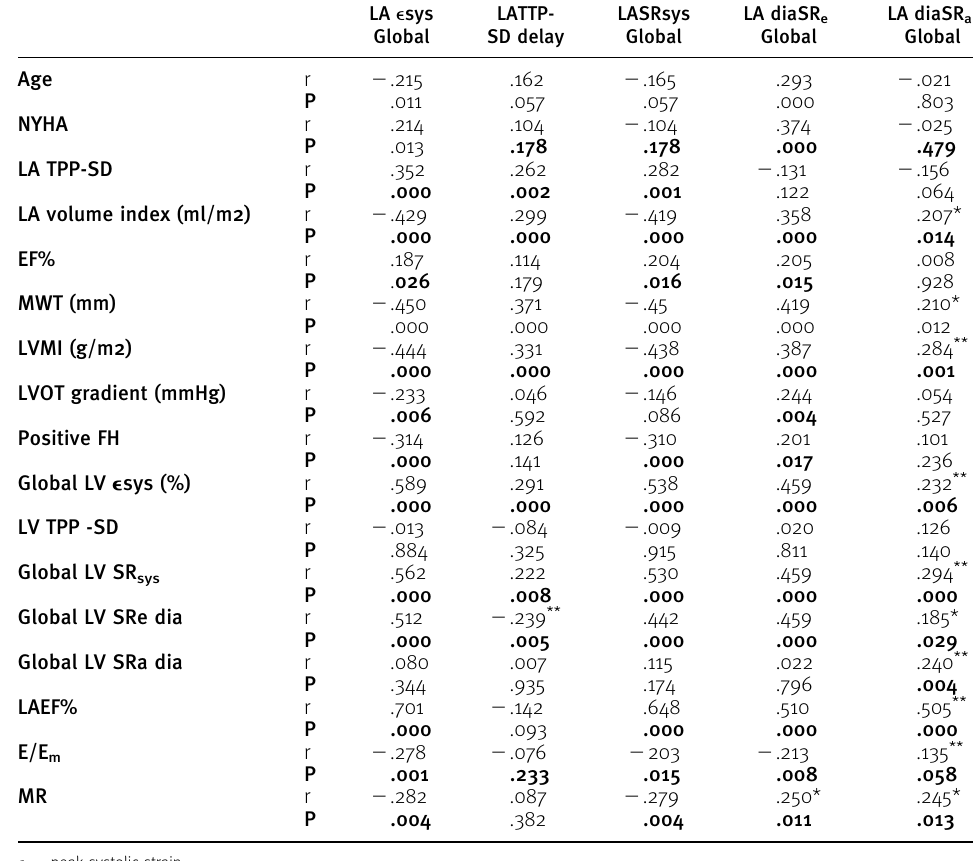
Table 3. Correlation between left atrial deformation, clinical and other echocardiographic